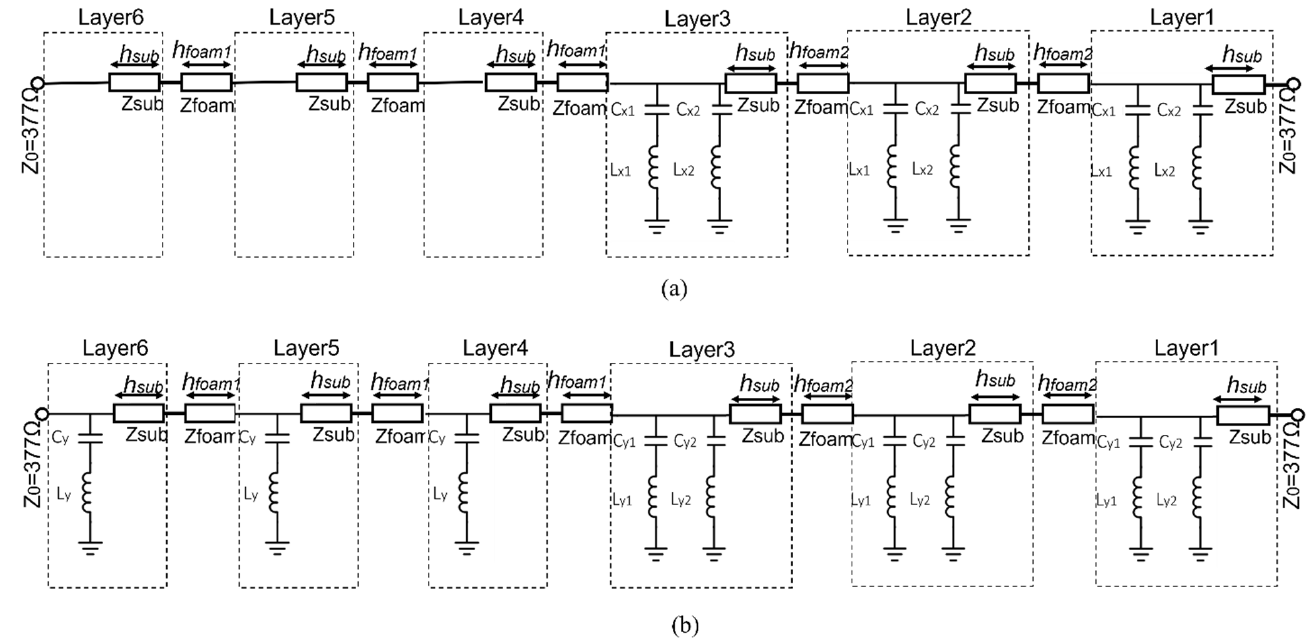
Figure 5. Equivalent circuit model of the multilayer polarizer for: ( a ) x-polarized input wave; ( b ) y-polarized input wave.